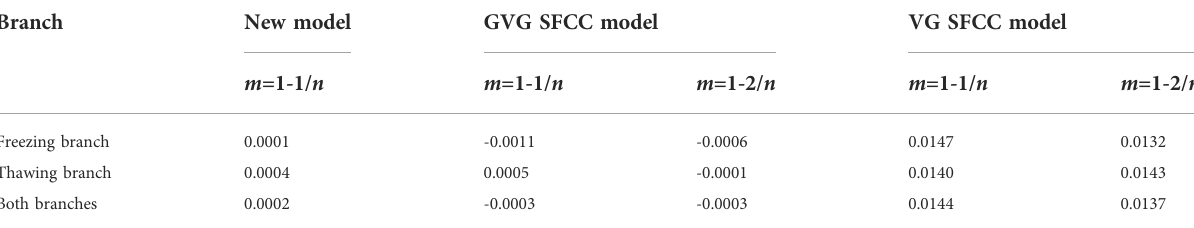
TABLE 4 AD for different SFCC